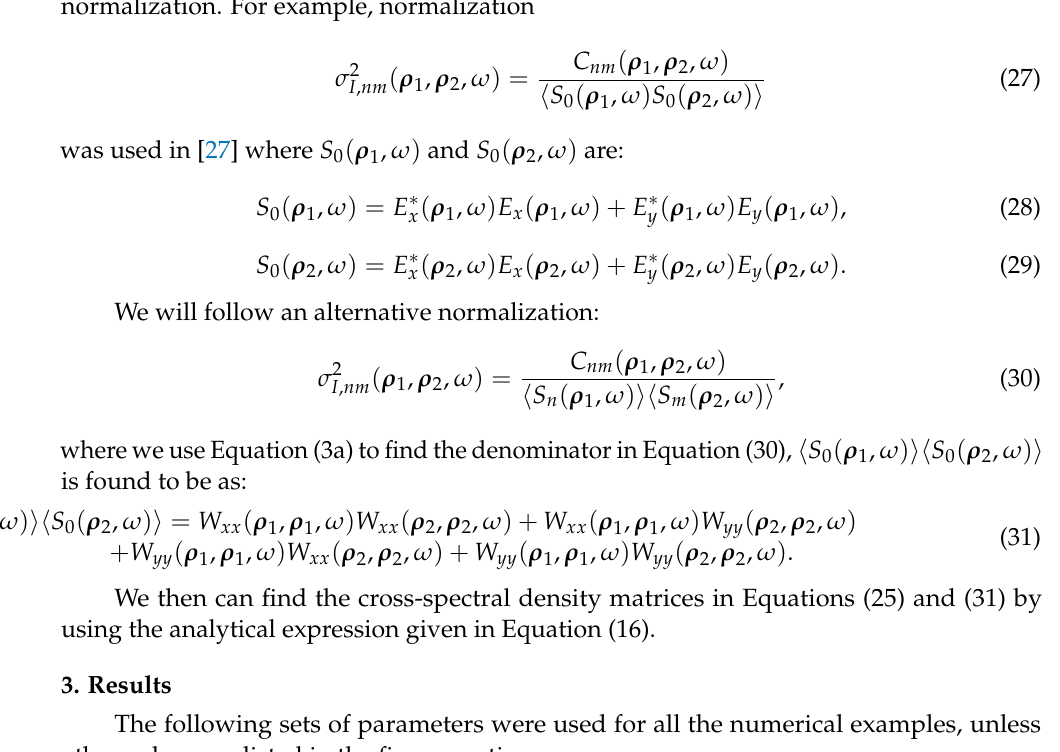
Figure 1A: λ = 0.628 µ m, σ = 2.5 cm, δ xx = 1.5 mm, δ yy = 2 mm, δ xy = δ yx = 2.5 mm, A x = 1.5, A y = 1, B xy = B ∗